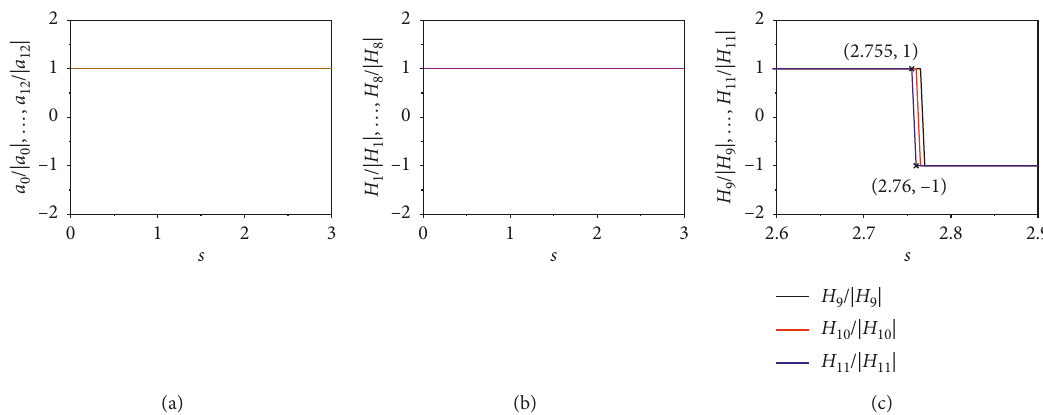
Figure 5: The coefficients of the characteristic equation and Hurwitz determinants change with the